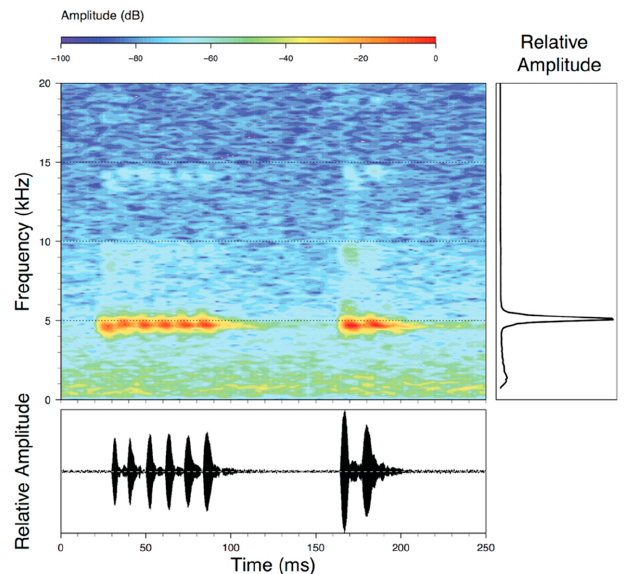
Figure 39. Call of Centrolene heloderma (LBE-C-012) recorded from Reserva Las Gralarias, Pichincha province, Ecuador. Note that each call has two distinctive pulsed notes.